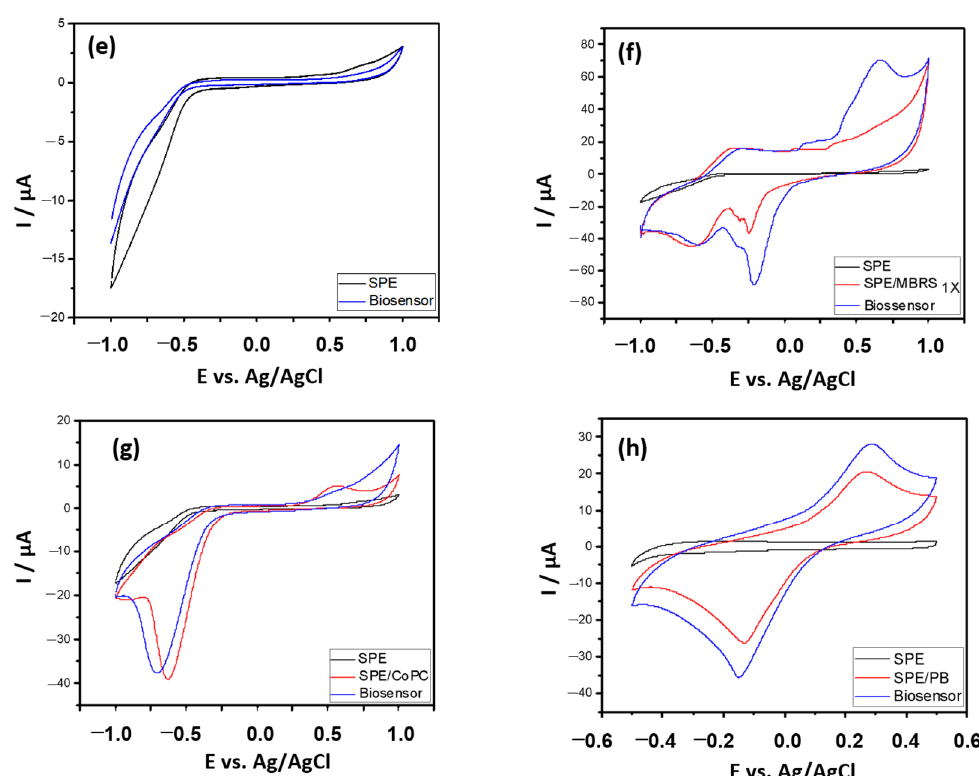
Figure 2. Cyclic voltamogram of ( a ) carbon paste electrode (SPE), ( b ) SPE modified with meldola blue with Reinecke salt (MBRS), ( c ) SPE modified with Cobalt phthalocyanine (CoPC), ( d ) SPE modified with PB and biosensors ( e ) without mediator and mediated with ( f ) MBRS, ( g ) CoPC, and ( h ) (PB) in K-PBS 50 mmol · L −1 pH 7.5. Scan rate 50 mV · s −1 .